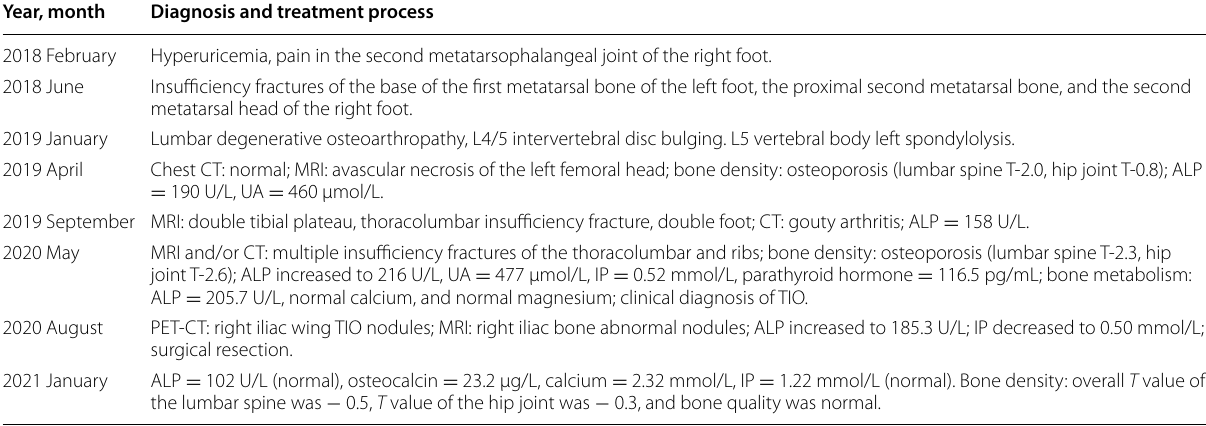
Year, month Diagnosis and treatment process Hyperuricemia, pain in the second metatarsophalangeal joint of the right